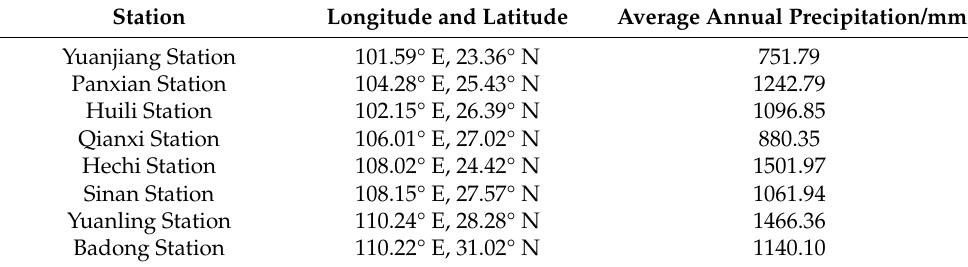
Table 1. Average annual precipitation of sites for different provinces.